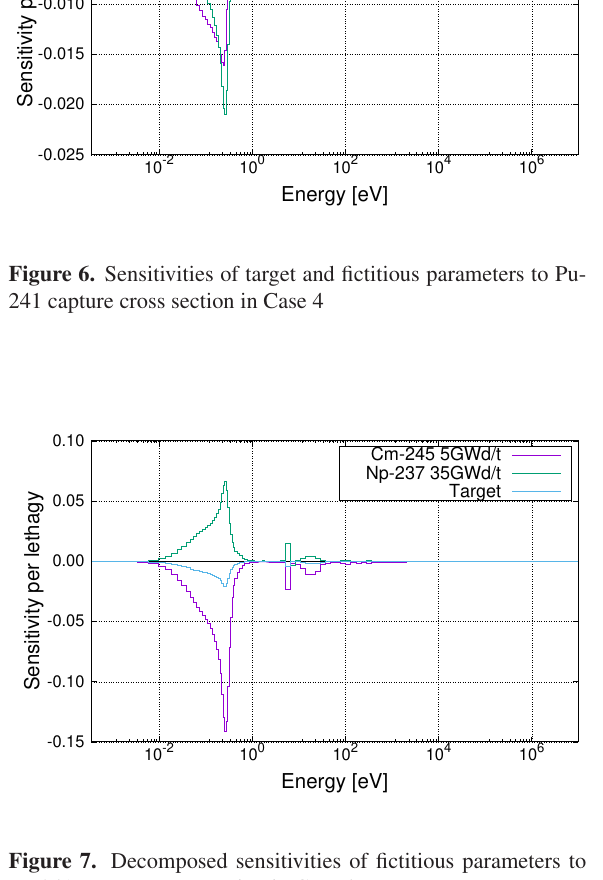
The above calculations use the extended bias factor method that deals only with errors due to nuclear data